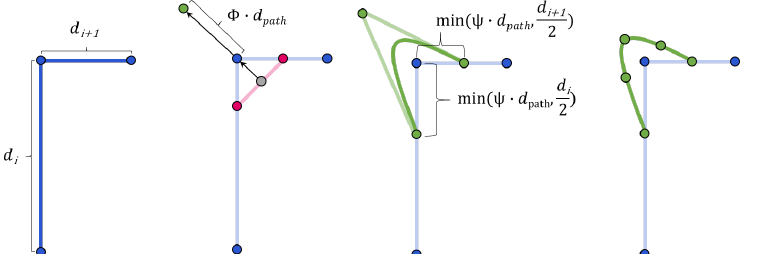
Figure 2. Concept of smoothing and stretching of welding path presented by [10].